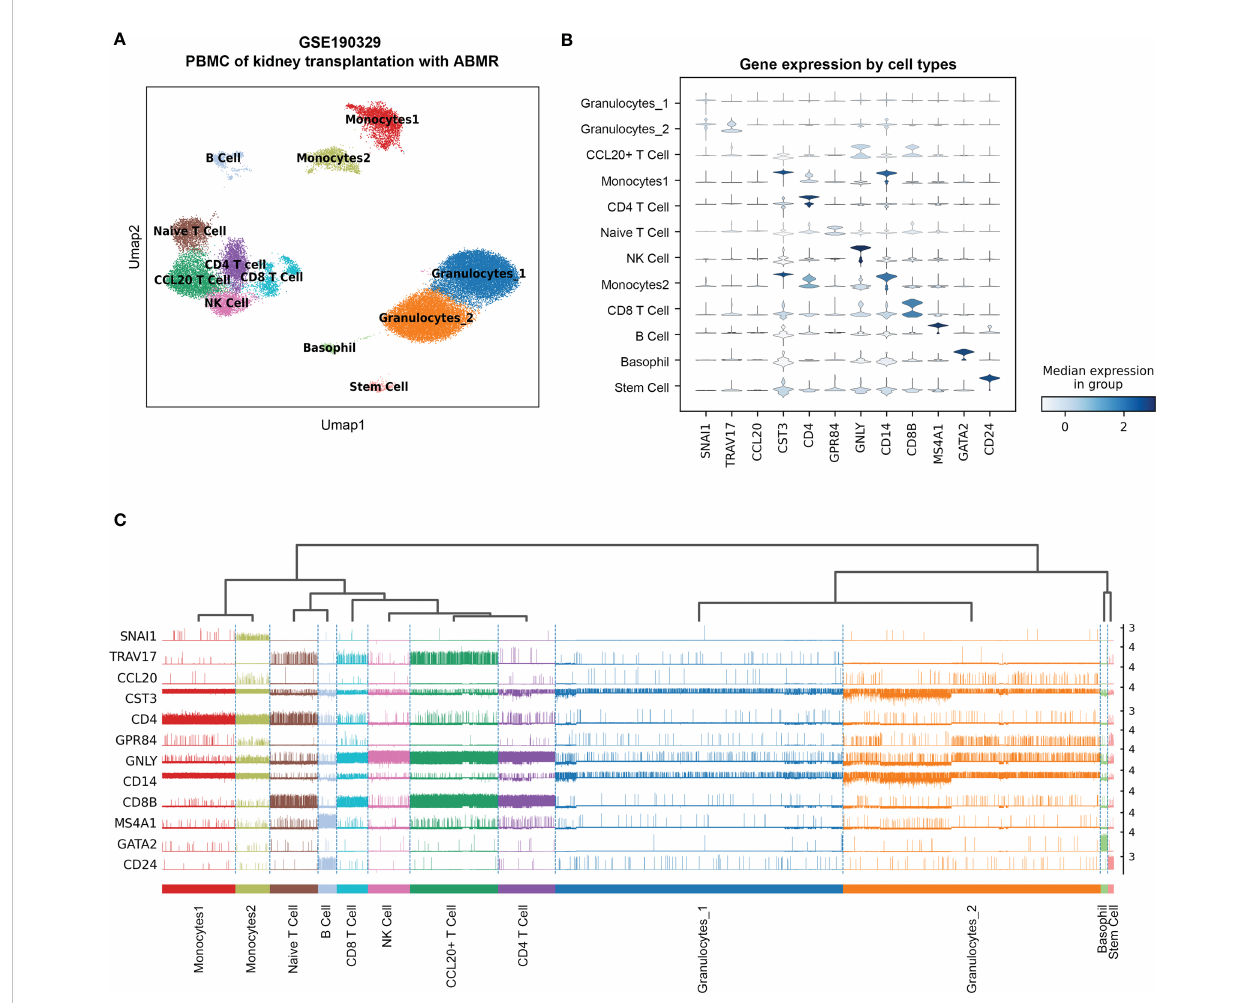
FIGURE 3 The re-analysis of single-cell RNA sequence data in PBMC with acute antibodies mediated rejection samples as the reference of the deconvolution. (A) UMAP dimension reduction analysis of cell type clusters from both Control and cABMR samples. (B) The violin plot of marker genes generated by Leiden cluster identify. (C) The tracksplot shows the marker genes expression by single-cell resolution grouped by cell types. UMAP: Uniform Manifold Approximation and